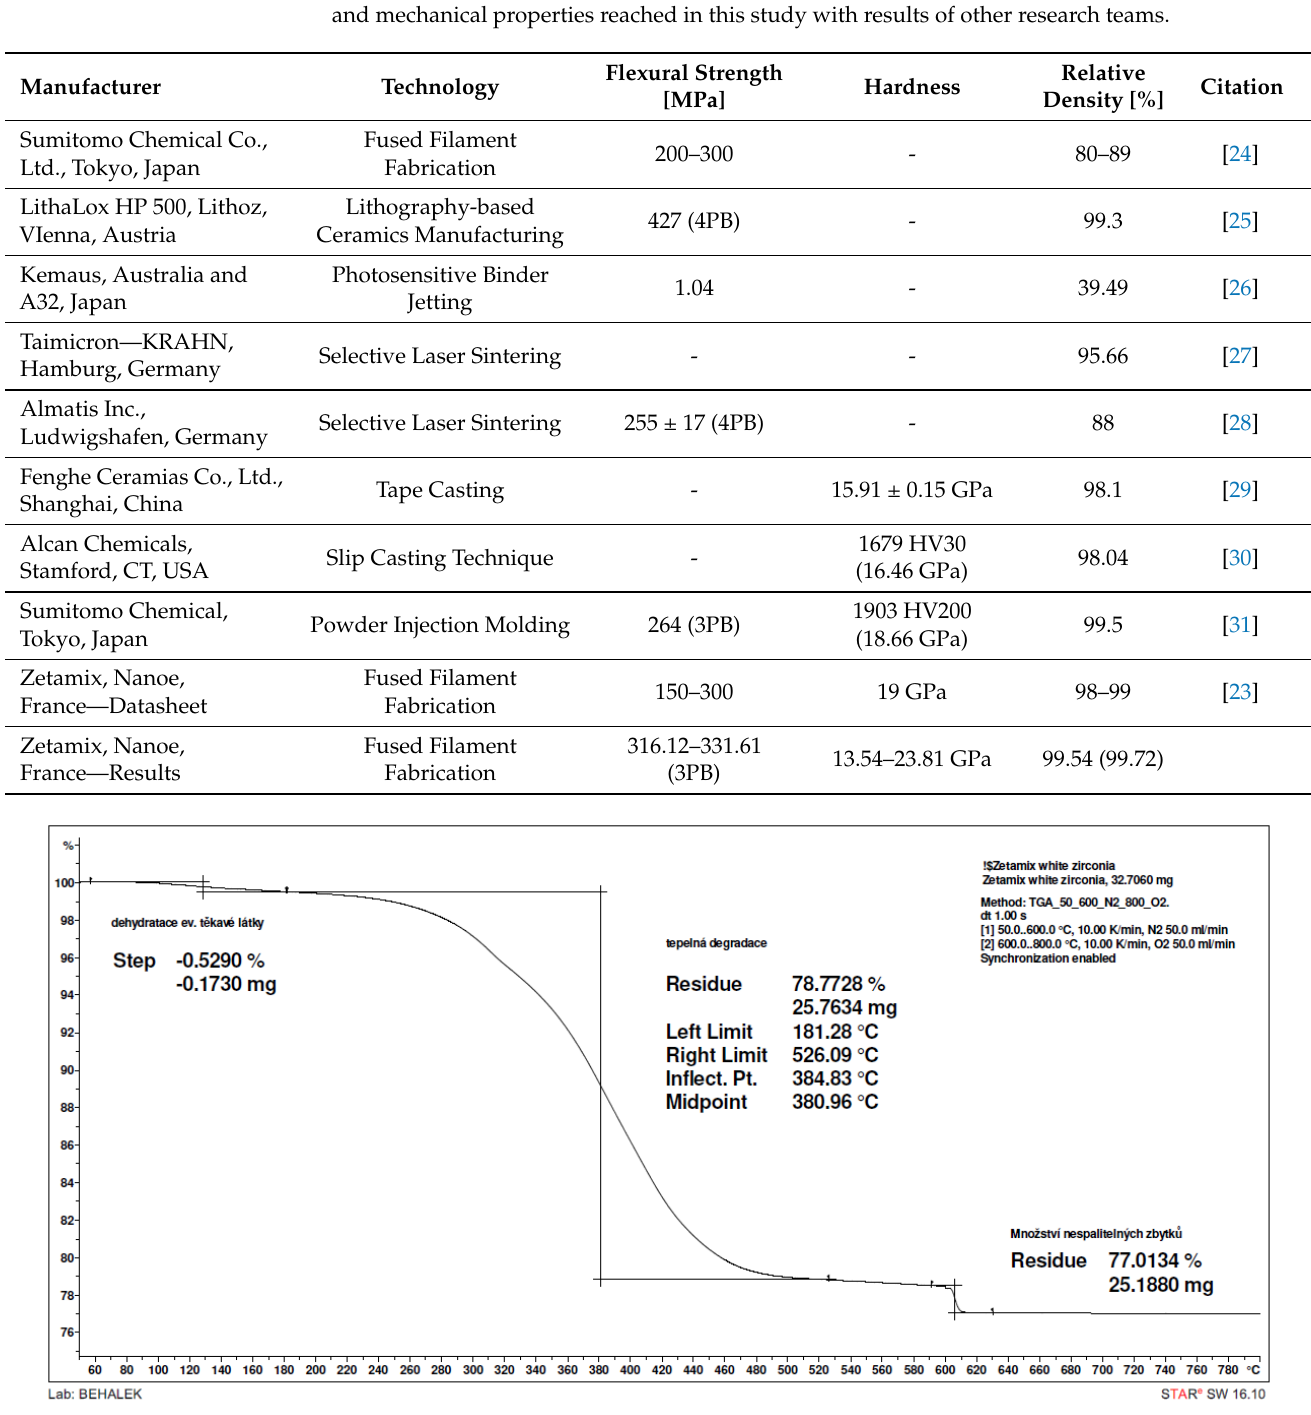
Figure 3. The thermogravimetric analysis of alumina material from Zetamix. Furthermore, the melt volume rate (MVR) was also measured. At a temperature of 150 °C and a total sample load of 2.16 kg, the resulting MVR value was (159 ± 6) cm 3 /10 min. The measurement was performed in accordance with the international standard EN ISO 1133-1:2011. The measurement conditions were used for a polyethylene matrix, which was previously verified by FTIR spectrometry. Energy Dispersive X-ray Analysis (EDX), was used to verify the composition of the Al 2 O 3 material on the sample before debinding and